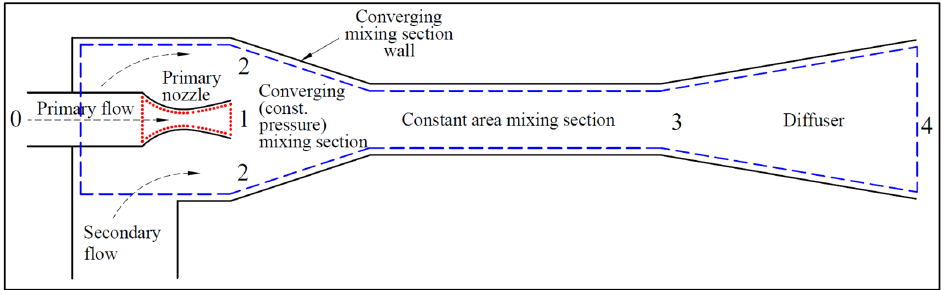
Figure 10. The dashed (blue) line and dotted (red) lines are showing control volumes A and B, respectively.